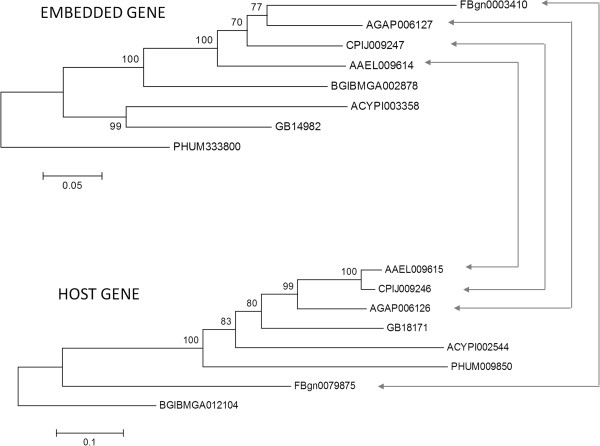
Neighbor-joining phylogenetic trees of a representative gene pair among different insect species. The positional overlapping (one gene embedded in another), if present in a species, is indicated by arrowed lines connecting the corresponding genes between the two phylogenies. The alphabetic letters associated with gene IDs shown in the tree correspond to the species as follows: AAEL- A. aegypti, AGAP- A. gambiae, CPIJ- C. quinquefasciatus, FBgn- D. melanogaster, GB- A. mellifera, PHUM- P. humanus, BGIBMGA- B. mori and ACYP- A. pisum. The scale for branch length is shown below each tree.